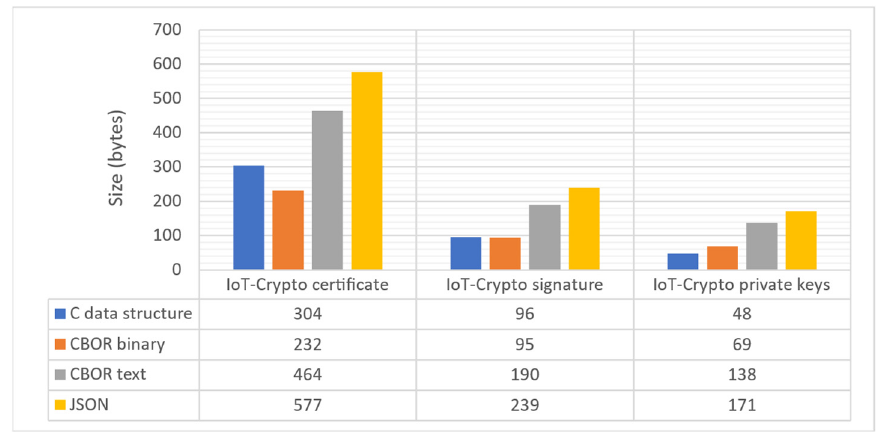
Figure 10. Sizes of IoT-Crypto data structures using various encodings (CBOR data can be stored in binary format or as a hexadecimal string, which is twice as long).